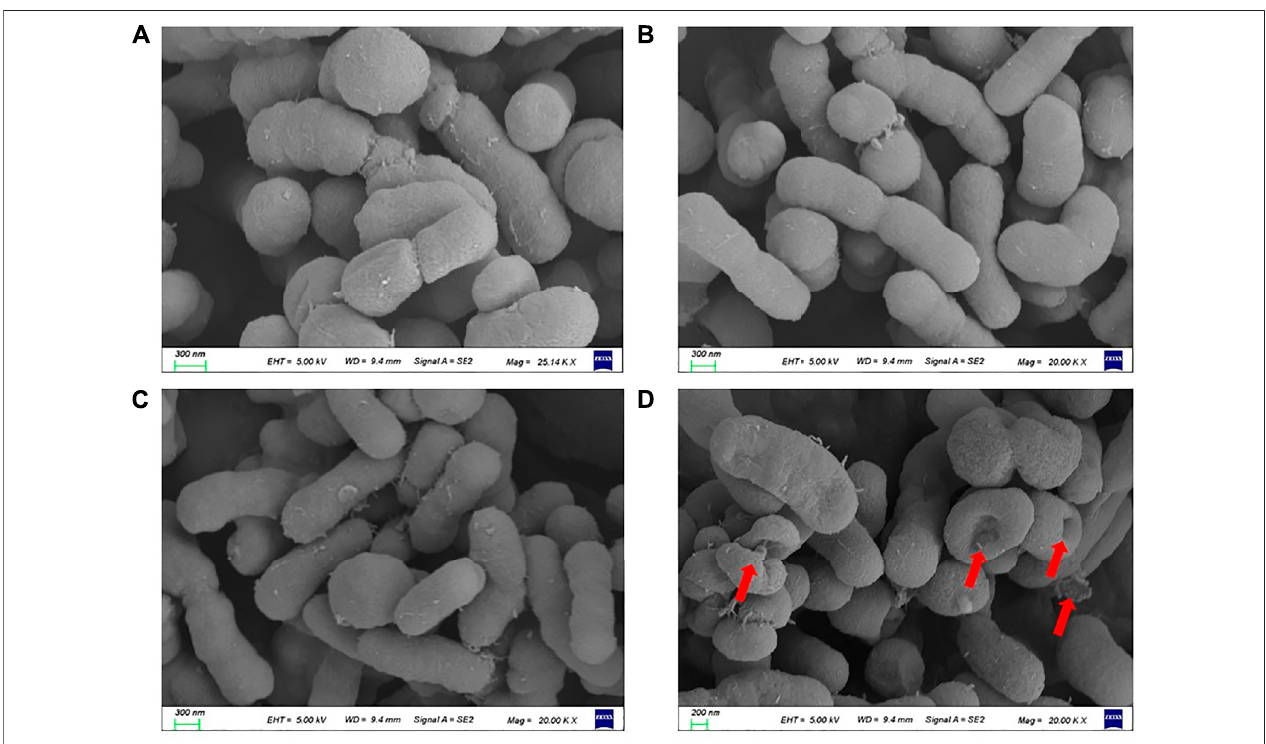
FIGURE 7 | Morphological changes of ATCC19606-R after different treatments. (A) : Untreated. (B) : Colistin (2 μ g/mL) alone treatment. (C) : Capsaicin (32 μ g/mL) alone treatment. (D) : Colistin (2 μ g/mL) combined with capsaicin (32 μ g/mL).